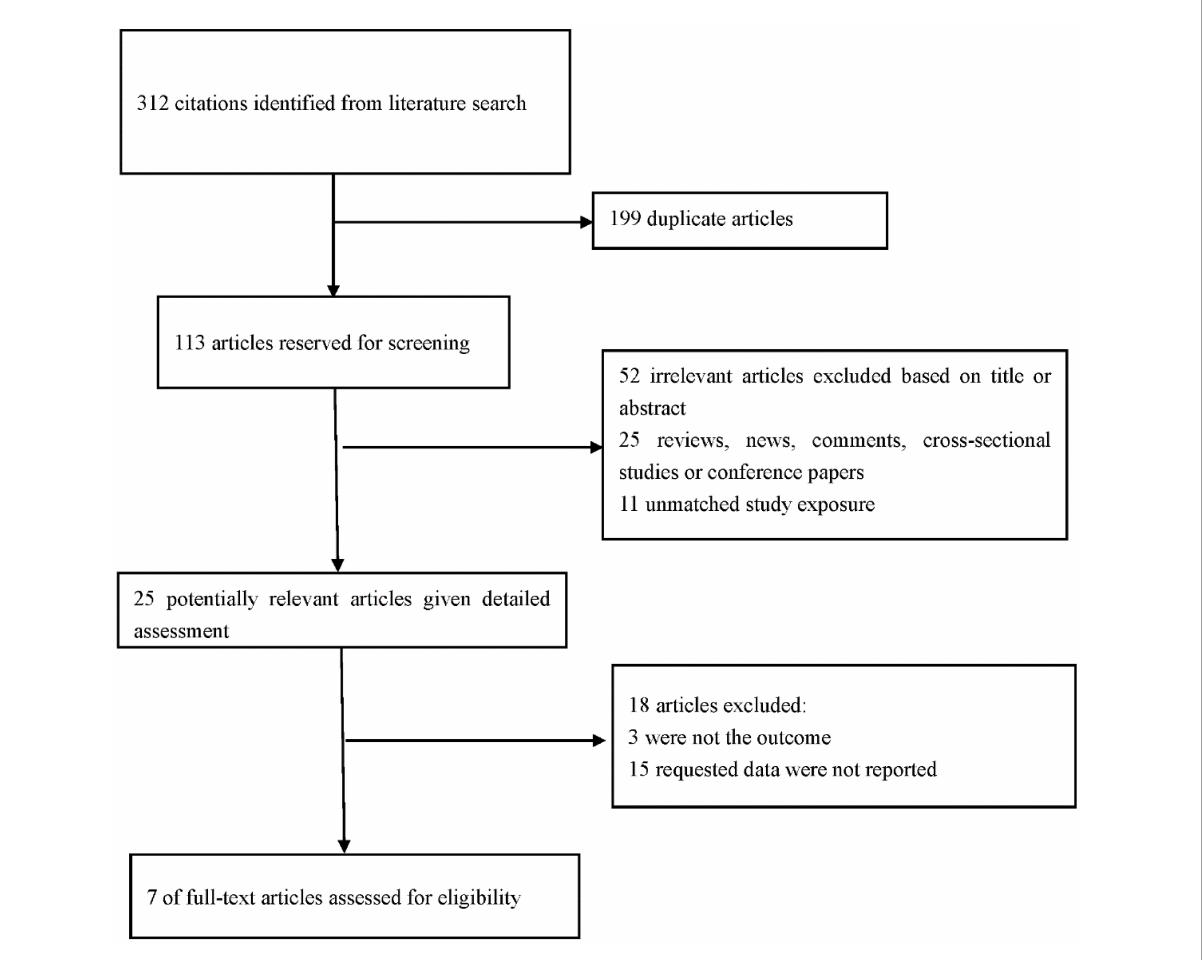
FIGURE1 Flow chart showing the process for selection of eligible